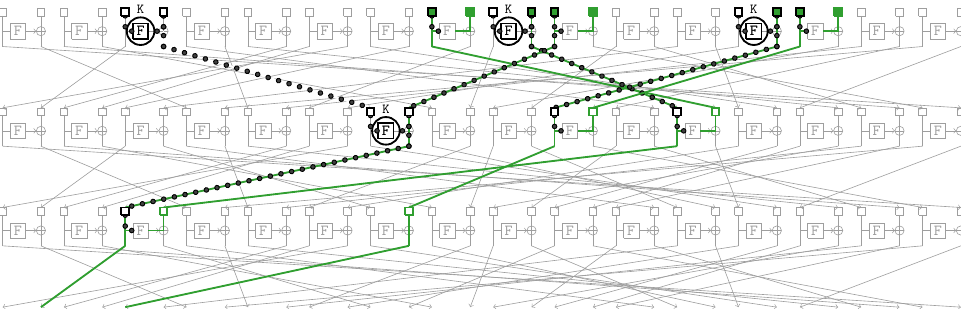
Figure 6: Determining the required key bits to apply [ZDM + 20] over 3